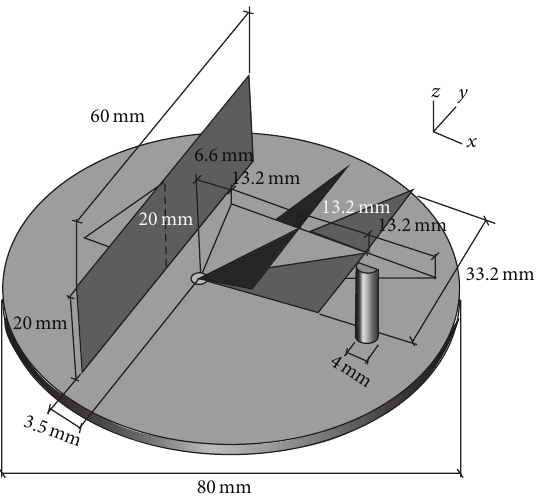
Figure 26: Dimensions of the planar directional UWB antenna for a lower cutoff frequency of 3 GHz.